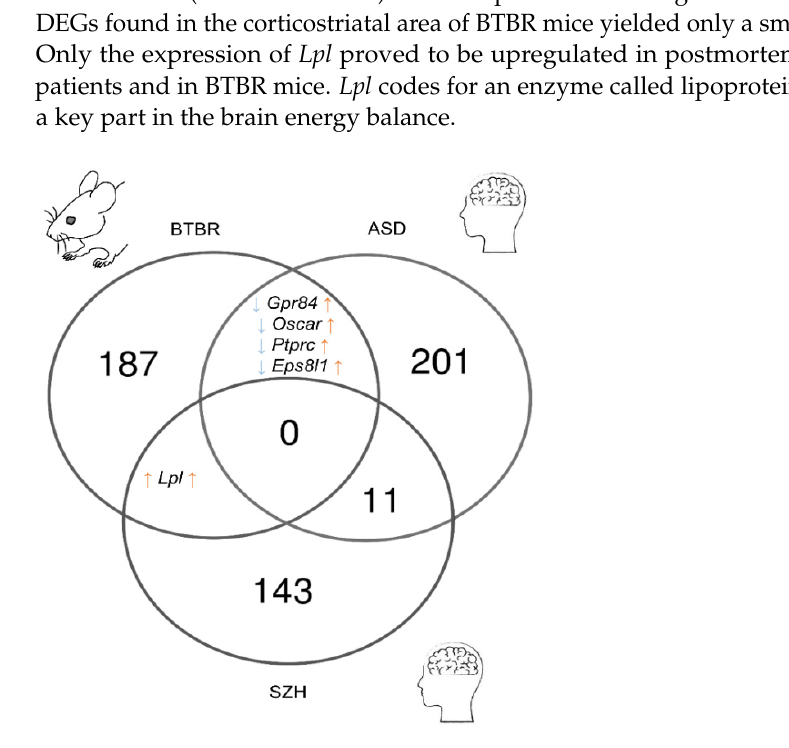
Figure 5. The comparison of reproducible DEGs between the corticostriatal area of BTBR mice and postmortem samples from the frontal cortex of SCZ and ASD patients. Numbers on the diagram represent how many genes are unique for the dataset and how many overlap.